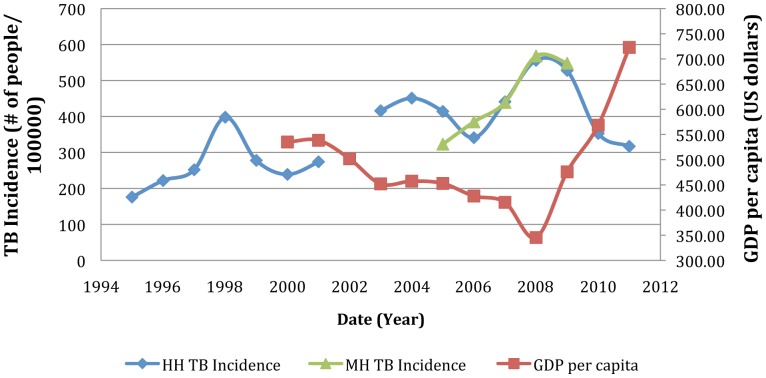
TB incidence at HH and MH versus GDP per capita in US dollars.GDP per capita is used to measure the average economic wellbeing of the Zimbabwean population. Source GDP per capita (In US dollars): World Bank [11].